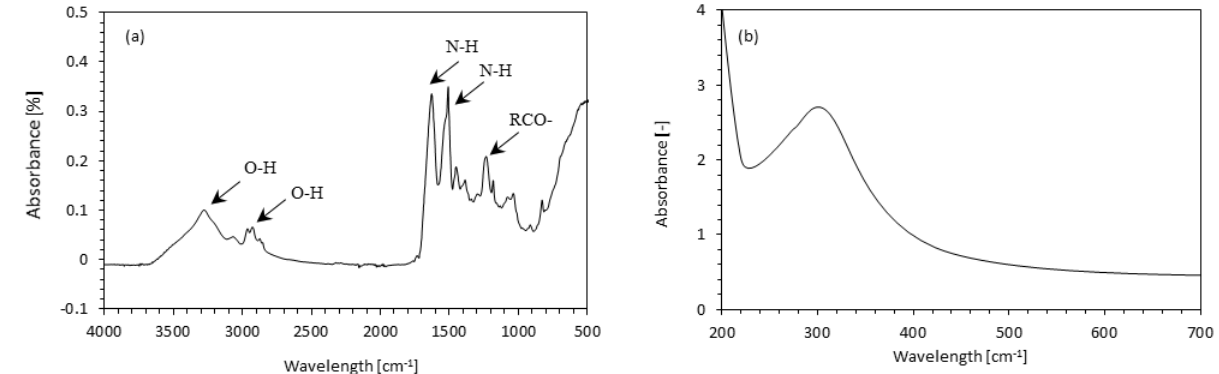
Figure 5. ( a ) FTIR spectrum and the ( b ) UV-Vis spectrum of casein/apricot